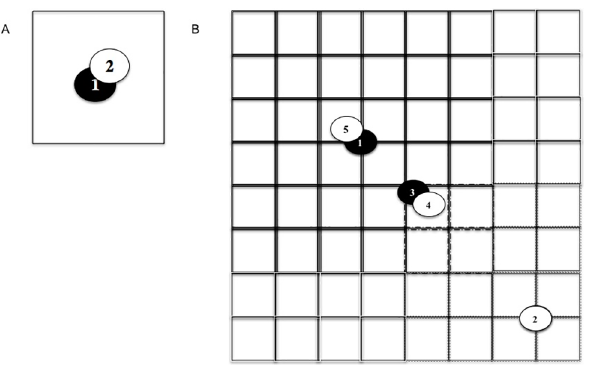
Fig 2. Measuring recurrencebetween depredation events at multiple spatial scales. Each small rectangle is a section (1 mile 2 ). Each oval is a singleevent of verifieddepredation. A 1 indicatesthe first of such events in its vicinity and year, and highernumbersare subsequent events in chronologicalorder of occurrence in the same year. The interventionis shown with coloredovals: lethal(black), non-lethal intervention (open); and events withinthe same sectionare depictedas overlappingeach other partially(1 and 2 in A; 1 and 5 or 3 and 4 in B). A : Smallest scaleof analysiswhere the vicinity is limited to the section. Datum 1 stratum 1 measuresthe numberof days betweenevents 1 and 2 with lethalintervention.Becausethere is no event 3 within the vicinity,datum 1 stratum 2 measuresthe numberof days betweenevent 2 and the end of the calendar year but switches to non-lethalintervention (openoval). B : Medium-scale of analysiswhererectangles are sectionsin a township(36 miles 2 centeredon event 1). Solidblack grid lines indicatebuffer aroundevent 1; dottedgray lines indicatebuffer aroundevent 2; blackdot-dashedlines indicateoverlapbetweenbuffers. Becauseevent 1 and event 2 are not in the same township-sized buffer, they generatedatum 1 and datum 2 with lethalinterventionand non-lethalintervention, respectively. Datum 1 stratum 1 measuresthe numberof days betweenevent 1 and event 3. Althoughevent 3 is also withinthe buffer of event 2 (within blackdot-dashed lines), it was assignedto event 1 becauseit was nearest by Euclideandistance.We did not measurethe numberof days betweenevents 2 and 3 becauseevent 3 was alreadyused to create datum 1 stratum 1; in this way, we avoideddouble-counting events. Next, events 3 and 4 are collapsed(treated as a singleevent) becausethey occurredin the same section sequentially .Becauseevent 3 was followedby lethalintervention (blackoval), the resultingsinglecollapsedevent was classifiedas lethalintervention.We then measuredatum 1 stratum 2 as the numberof days betweenevent 4 and 5, remembering that the collapsedevent is classified as lethaleven though4 is followedby non-lethalintervention (any collapsedset of events with a lethal intervention event amongthem is assignedto the lethalinterventionset). Finally,datum 1 stratum 3 is measuredby the numberof days betweenevent 5 and the end of the calendaryear and assignedto non-lethal intervention. If event 2 hadzero other events in its townshiparea (not shown),then datum 2 stratum 1 wouldbe measuredto the end of the calendaryear. A similar processwas followedfor the largest spatialscaleof neighborhood of townships(320 miles 2 ).